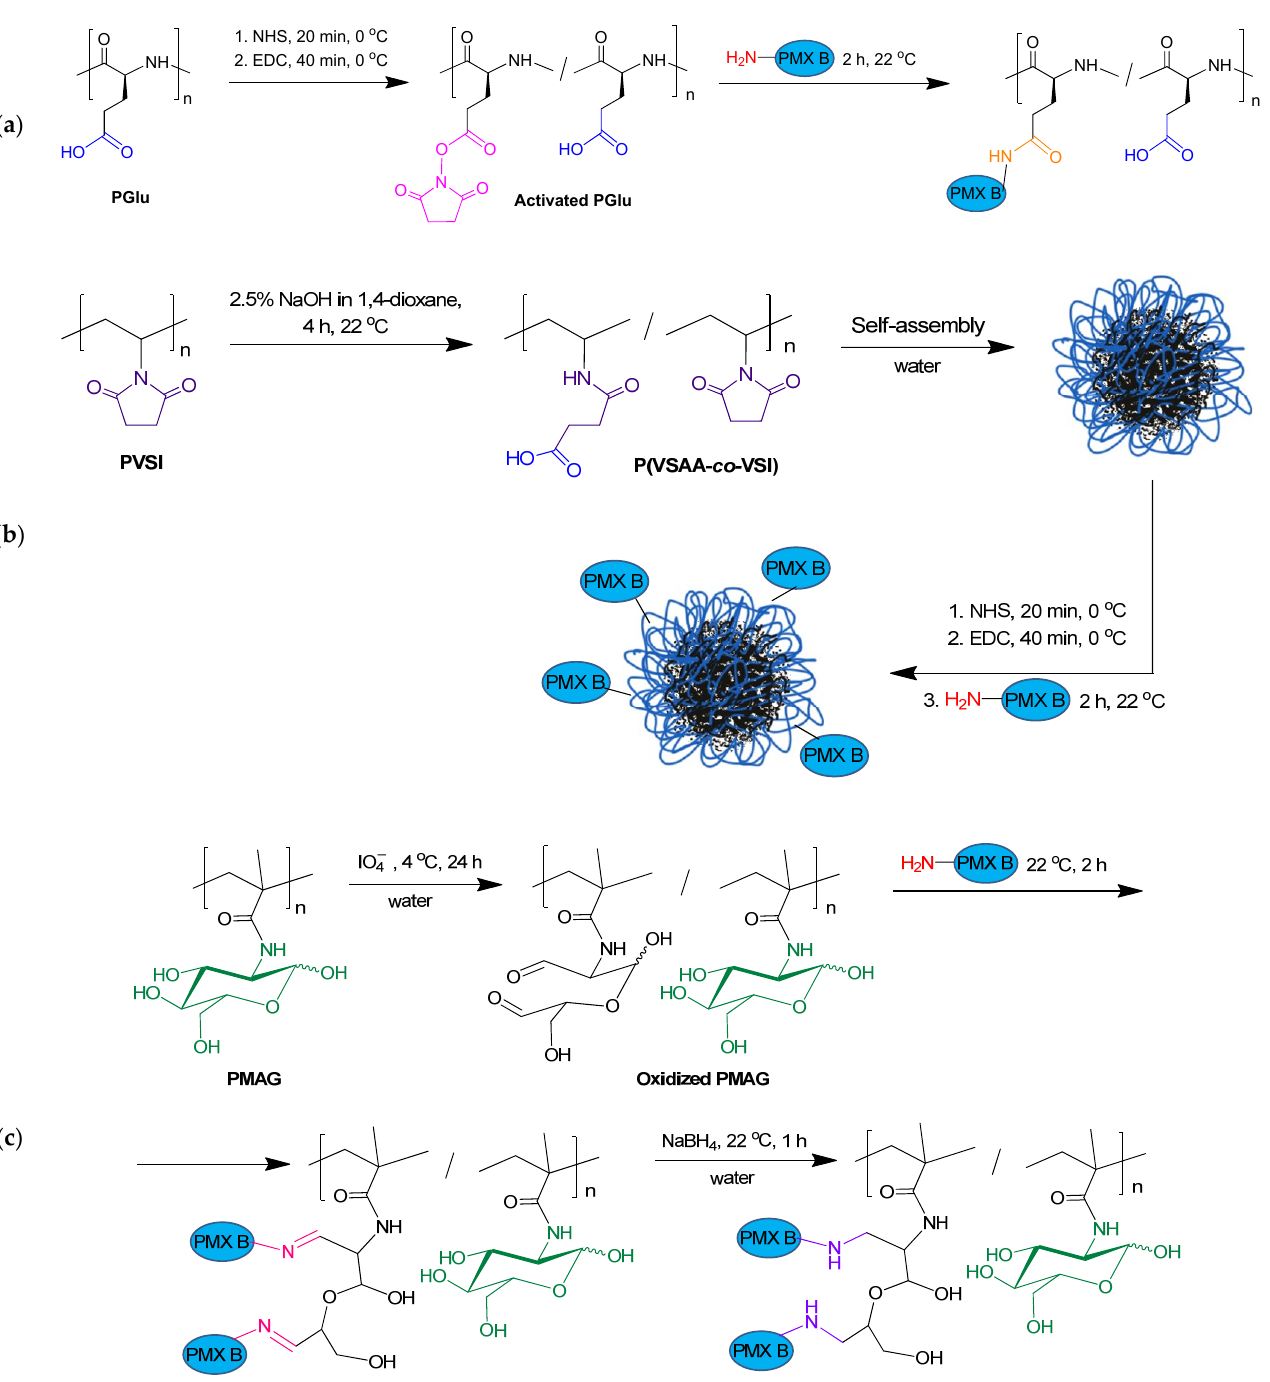
Figure 2. Scheme of modification of PGlu ( a ), PVSI ( b ) and PMAG ( c ), and conjugation with PMX B. For P(Glu- co -Phe), activation was performed as for PGlu, but the conjugate was in the form of modified nanoparticles as for P(VSAA- co -VSI).